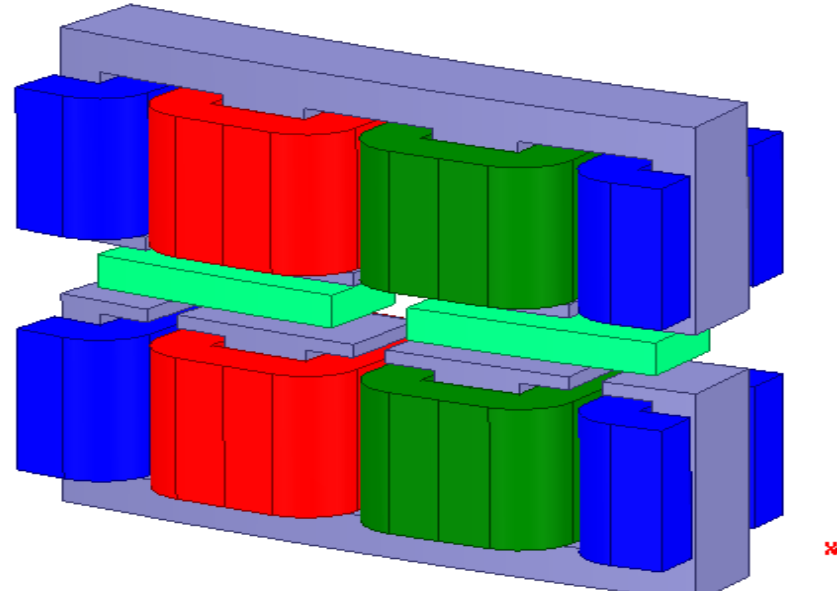
Figure 14. 3D geometry of the